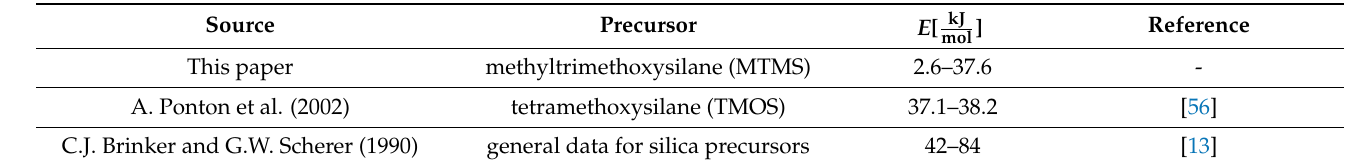
Table 4. Comparison of our results of activation energy and the literature data.